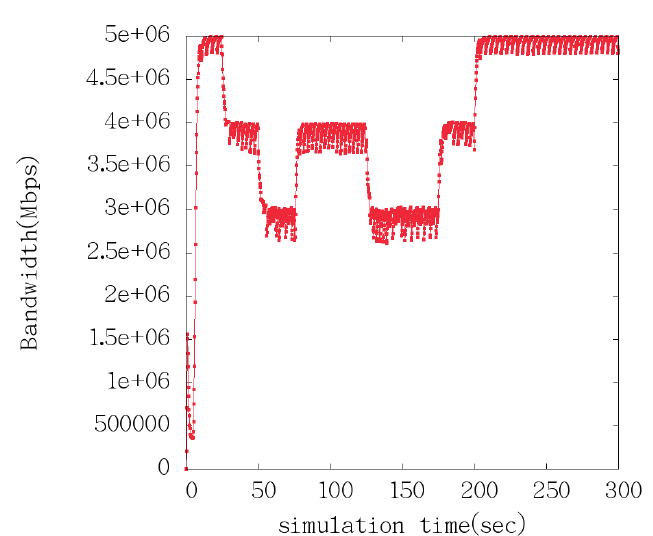
Figure 9. Bandwidth estimation.